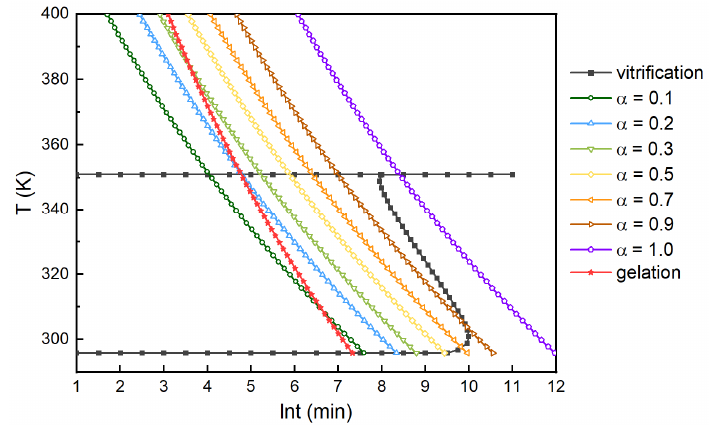
Figure 14. TTT diagram of the H 6 XDI/BES system.